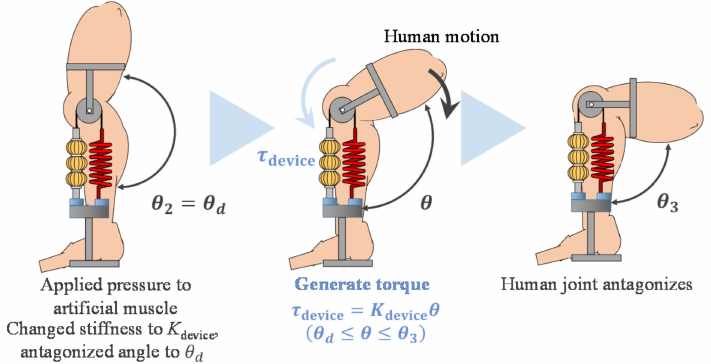
Figure 6. Passive assisted by the one-sided spring antagonized joint [18]. © IEEE